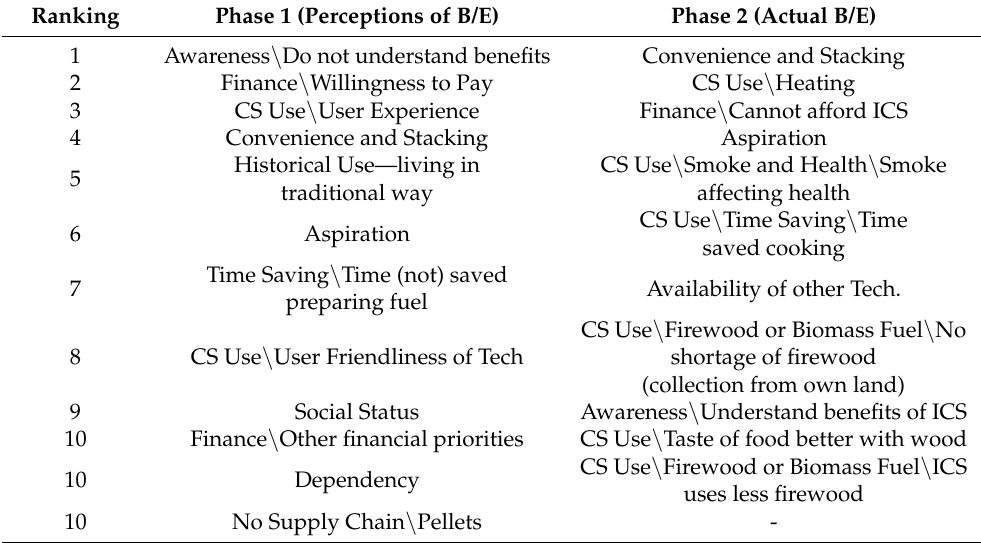
Table 3. Top 10 Barriers and